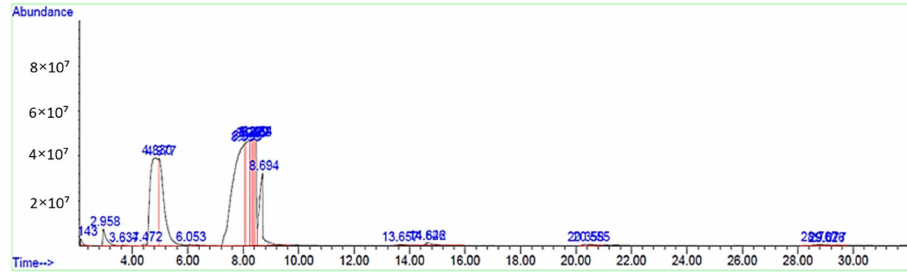
Figure 2. GC-MS chromatograph of